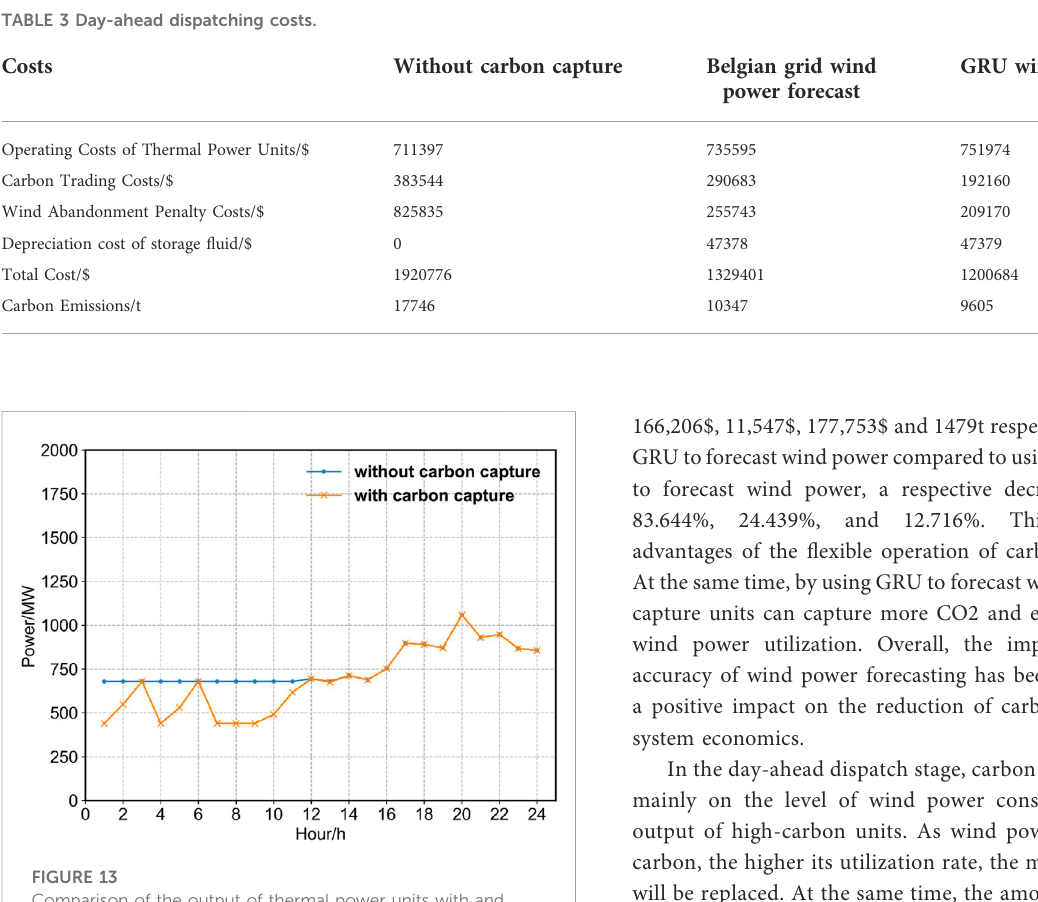
TABLE 3 Day-ahead dispatching costs.